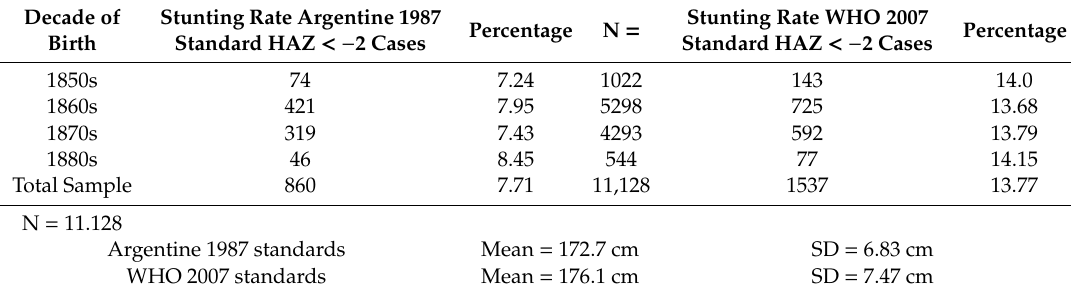
Table 2. Stunting rates by decade National Guards